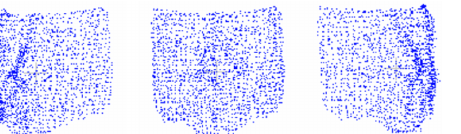
Figure 6. 2D images extracted from the final face clouds proposed by this work.